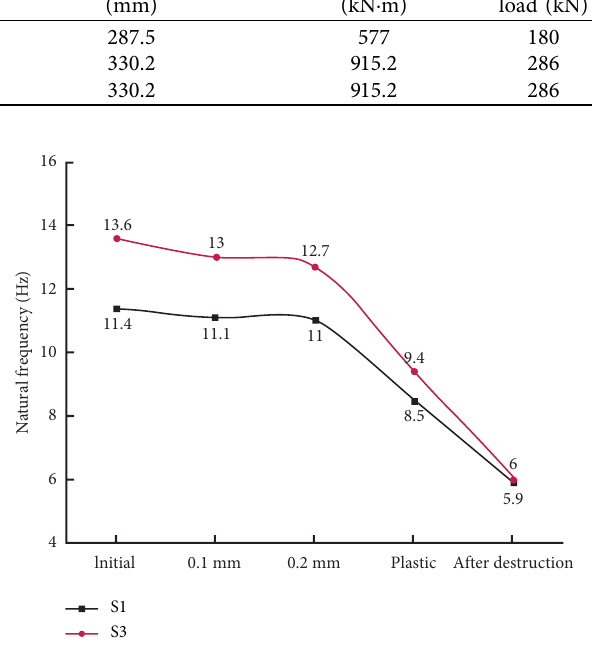
Figure 12: Effect of crack on natural